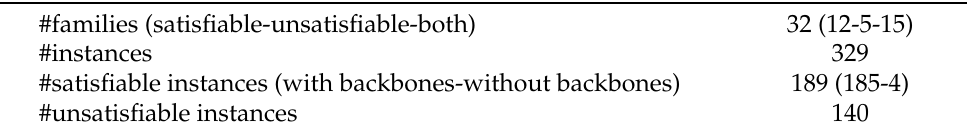
Table 2. A summary of industrial benchmarks used in the performance evaluation drawn from 2002–2021 SAT benchmark